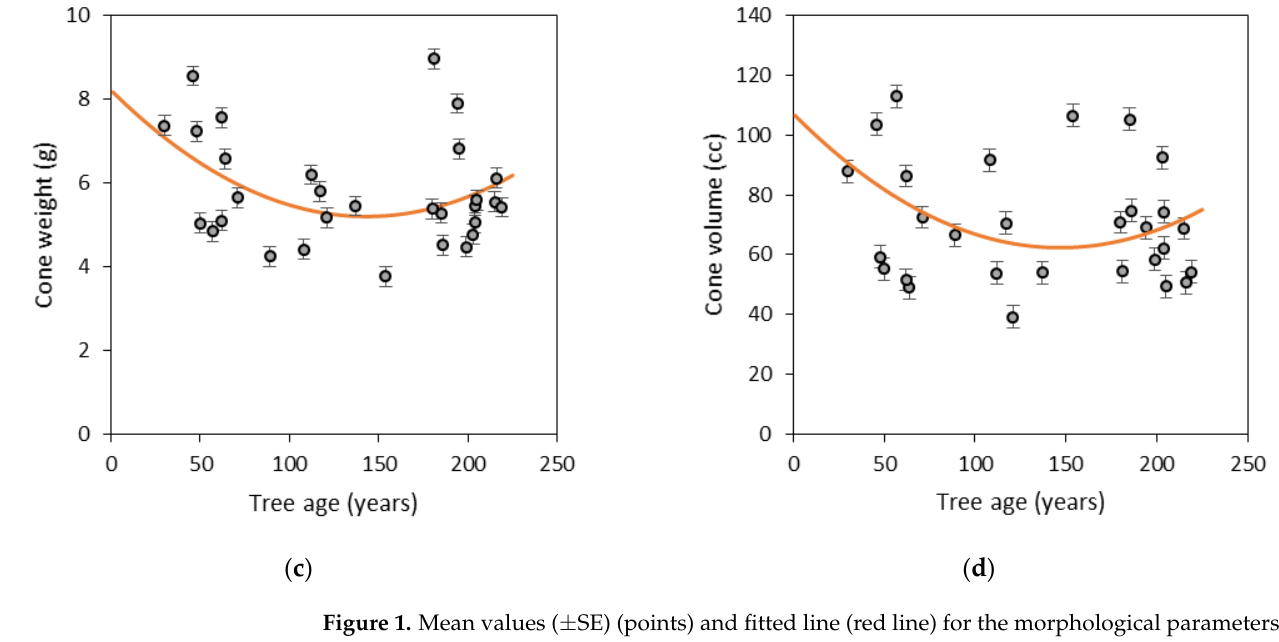
Figure 1. Mean values (±SE) (points) and fitted line (red line) for the morphological parameters of cones along the range of tree age analyzed: ( a ) length (in cm); ( b ) diameter (in cm); ( c ) weight (in g) and ( d ) volume (in cc). Fitted line is only shown for those traits showing a significant relationship with age.